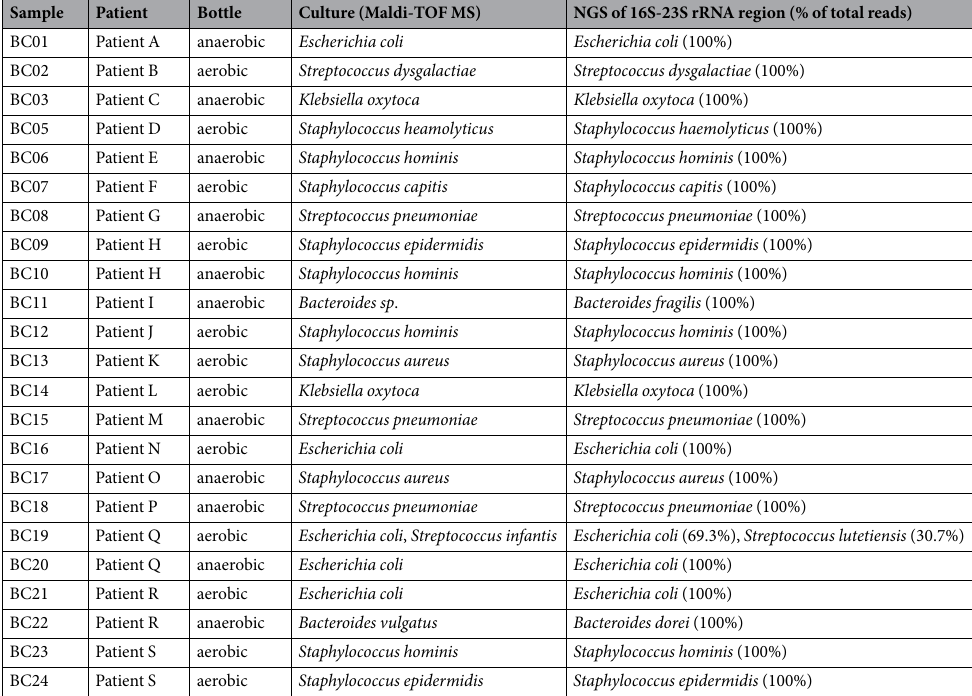
Table 2. Bacterial identification results from 23 positive blood culture bottles based on culture and NGS of 16S- 23S rRNA region.